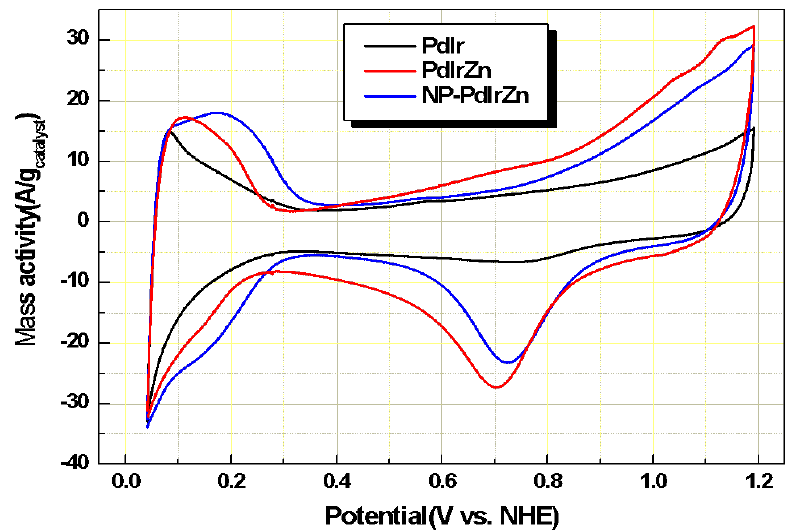
Figure 4. Cyclic voltammograms of PdIr, PdIrZn, and NP-PdIrZn catalysts.